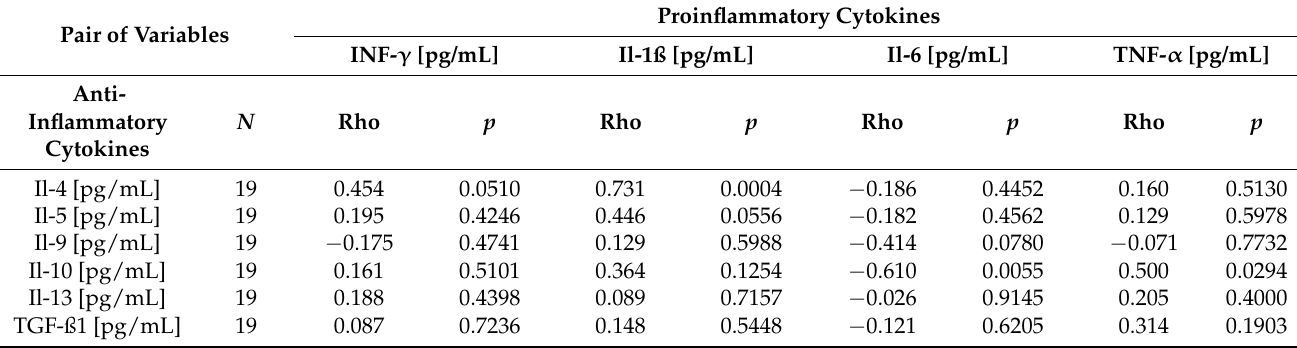
Table 4. Correlation of Spearman ranks between pro and anti-inflammatory cytokines evaluated in blood serum in control group.